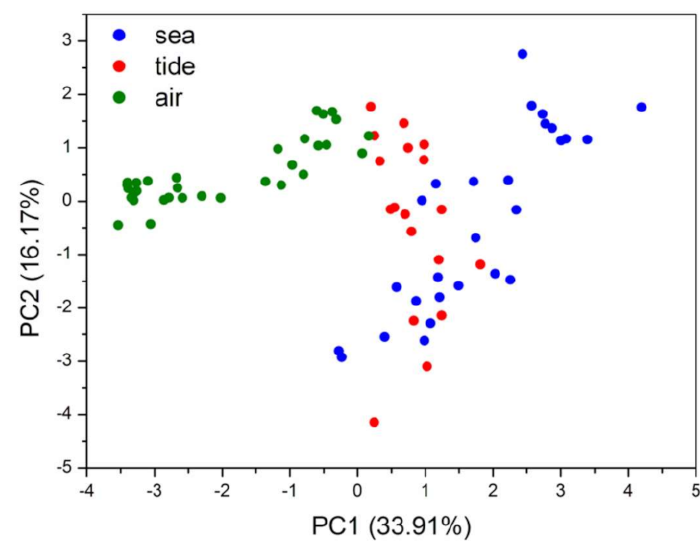
Figure 13. Score plot as a result of PC1 versus PC2 (after 12 months).